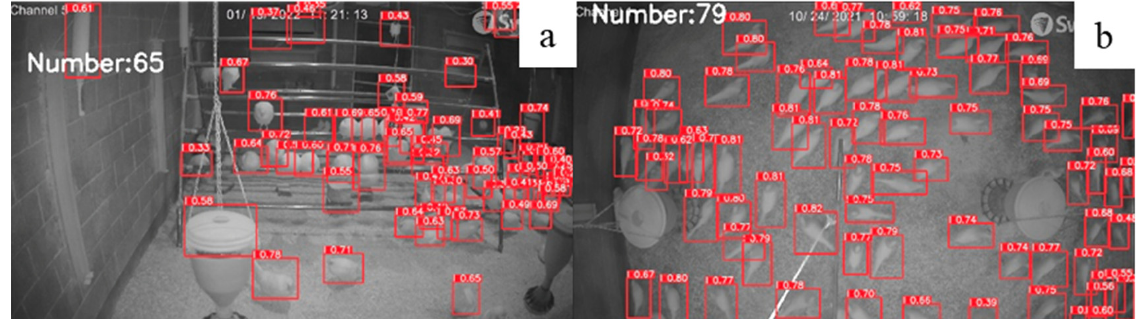
Figure 9. Number of chickens identified under horizontal angle and vertical angle by our model: horizontal angle ( a ) and vertical angle ( b ).